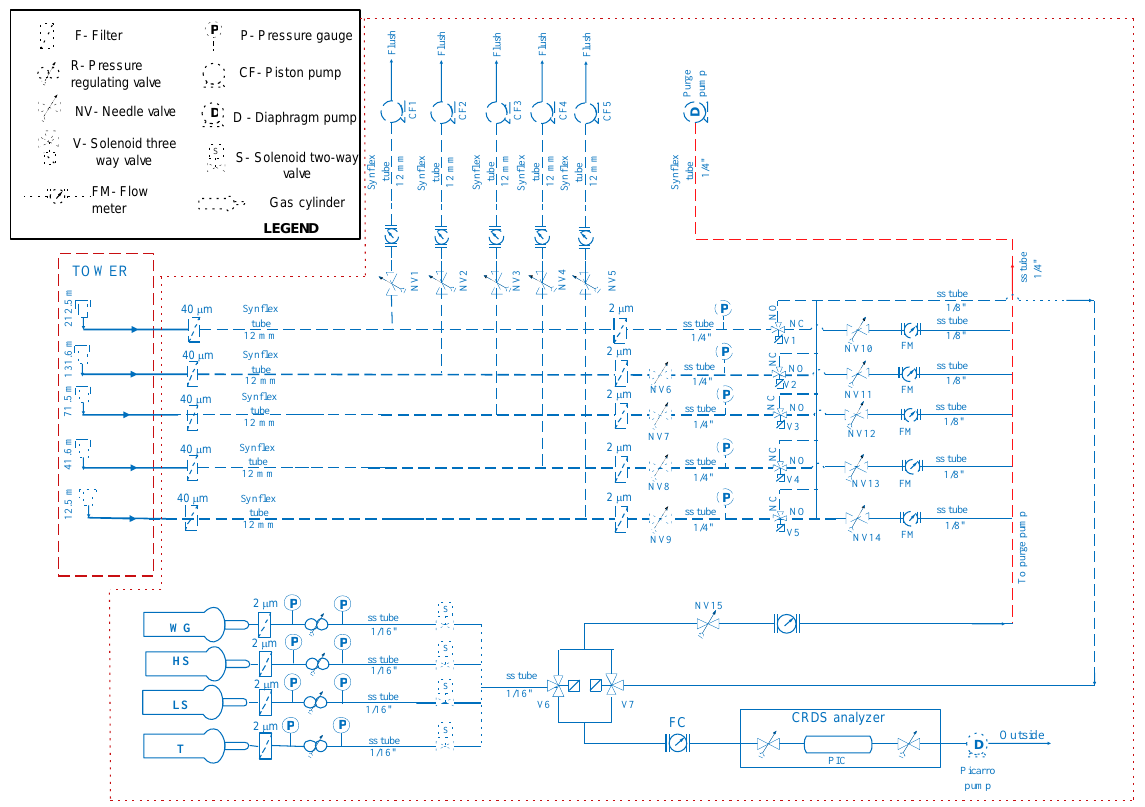
Figure 2. Schematic of the Beromünster greenhouse gases measurement system.